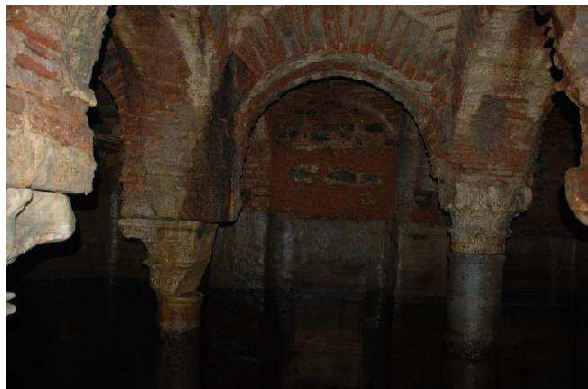
Figure 2. Hydraulic plastered walls of the cistern